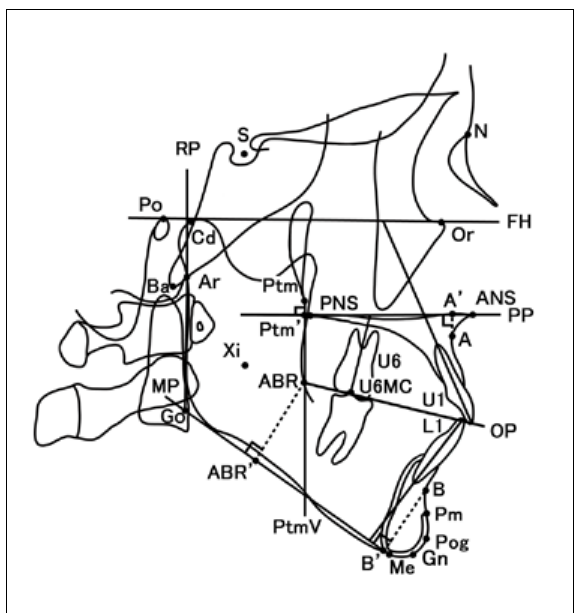
Figure 1. Reference points and lines